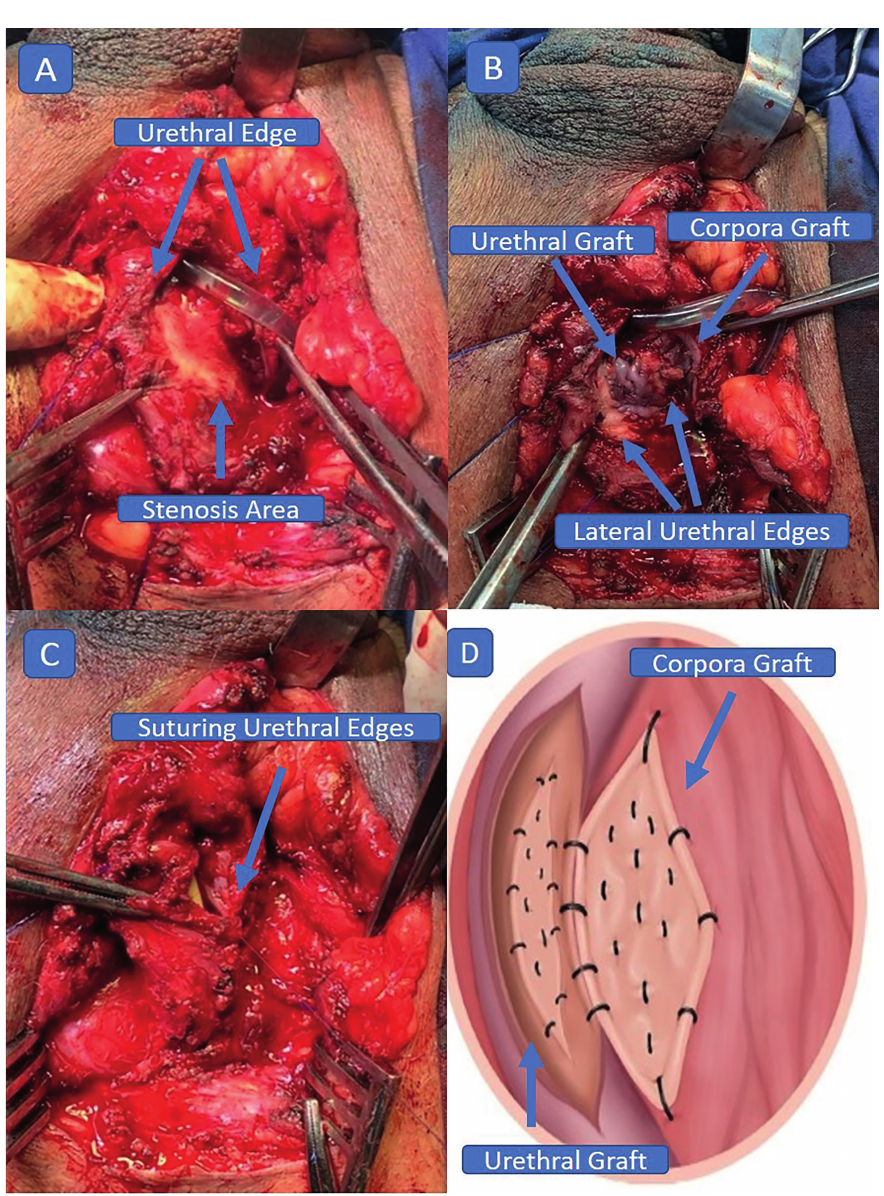
Figure 1 - (A) Longitudinal incision in the dorsal surface of the urethra, with rotation of 180°, (B) Oral mucosa dorsal onlay and ventral inlay graft, (C) Suturing of the edges of the urethra, (D) Schematic drawing showing placement of the mucosal